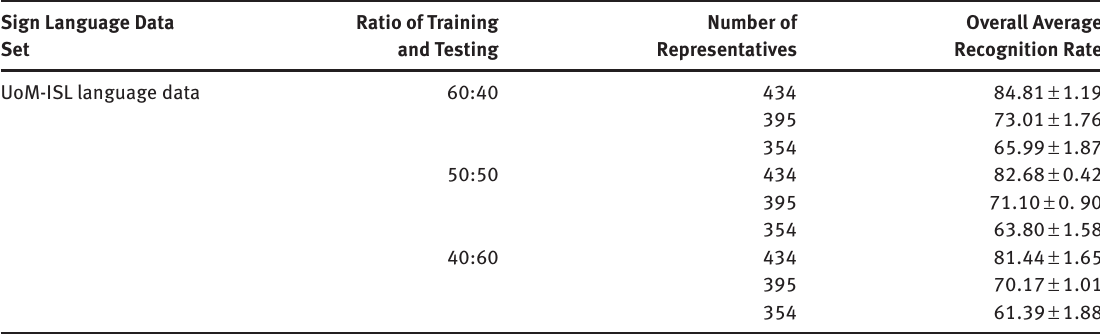
Table 2: Overall Average Recognition Performance of the Proposed Method in Terms of F-measure for Different Percentages of Training and